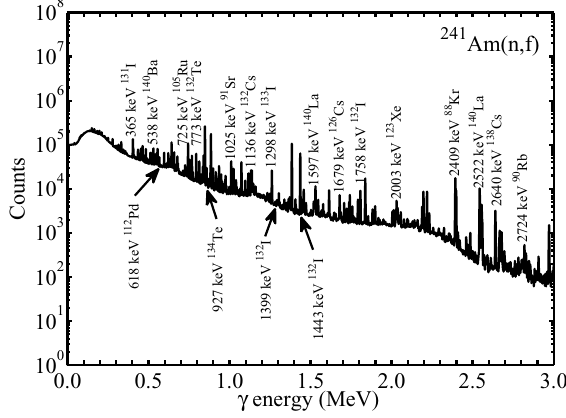
Figure 5. Typical characteristic γ -rays spectrum of 241 Am(n,f)